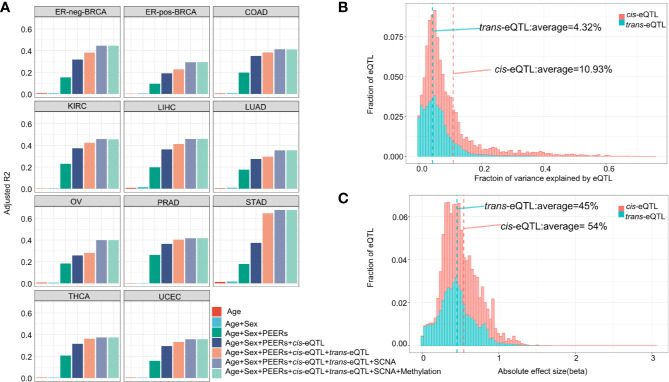
Effect size of eQTLs and other determinants of transcription. (A) Cumulative fraction of variance of elncRNA expression was calculated based on sequential addition of the following factors: age, sex, 5 PEER factors, cis-eQTL, trans-eQTL, somatic copy number alteration and DNA CpG methylation. The bars represent the average fraction of variance for all elncRNAs across 11 TCGA cancer types. Definitions of cancer types are provided in Table 1. (B) Histograms showing the distribution of the fraction of variance in gene expression explained by the cis/trans-eQTLs for elncRNAs aggregated across all cancer types. (C) Histogram showing the distribution of the absolute effect size (β) of cis/trans-eQTLs for all cancer types.